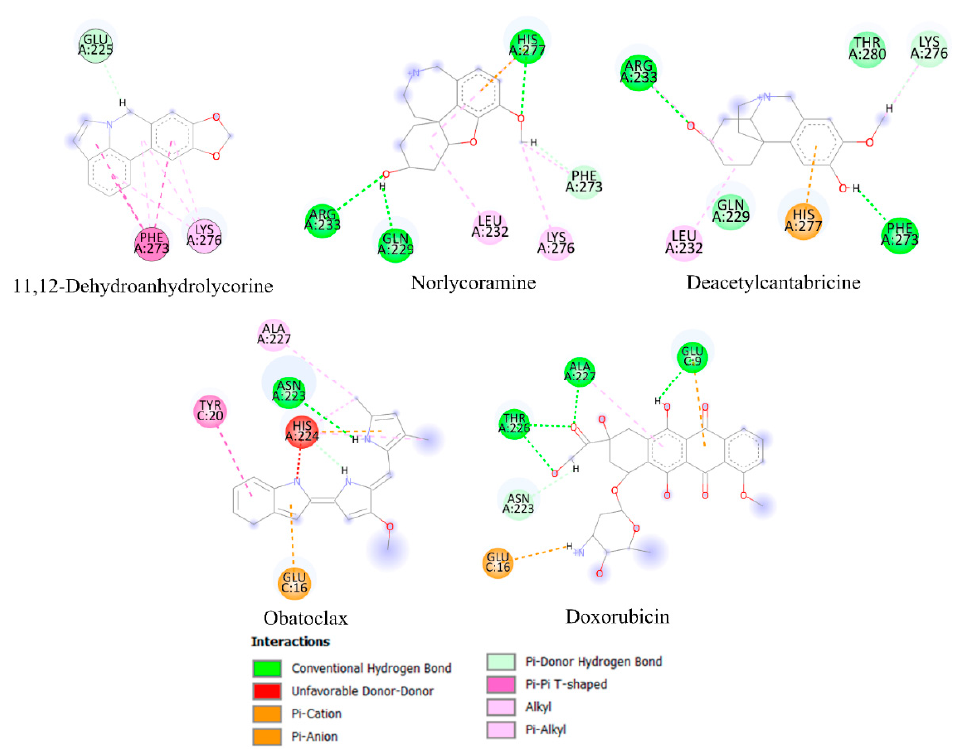
Figure 4. Principal interactions located by the molecular docking experiments between the ligands